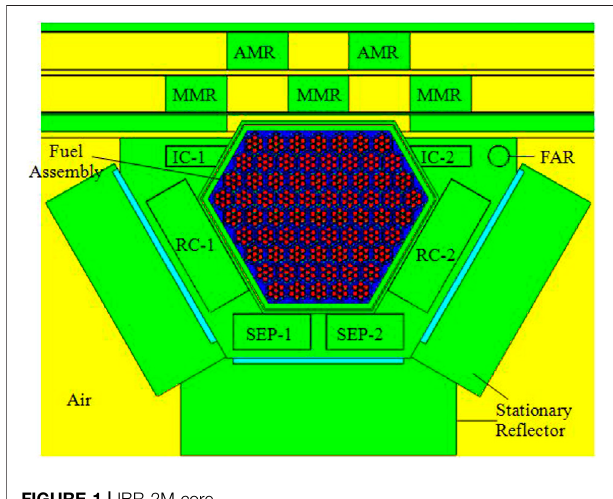
FIGURE 1 | IBR-2M core.